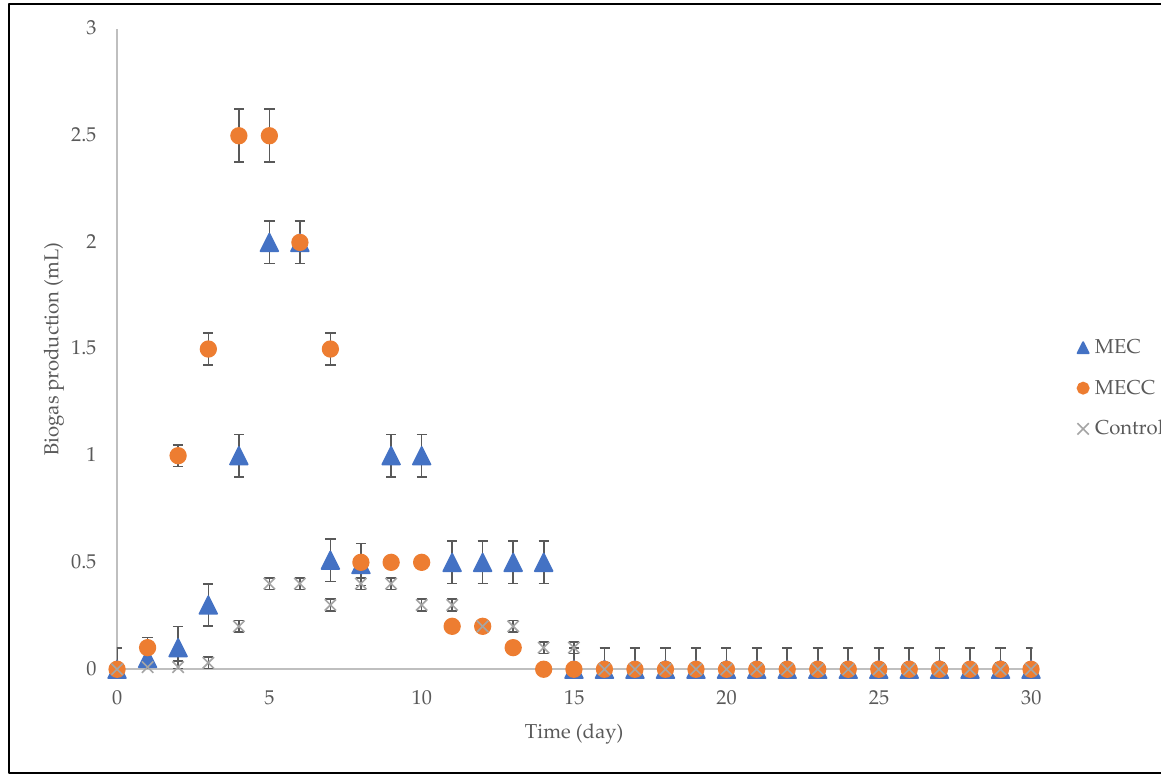
Figure 2. Daily biogas production.